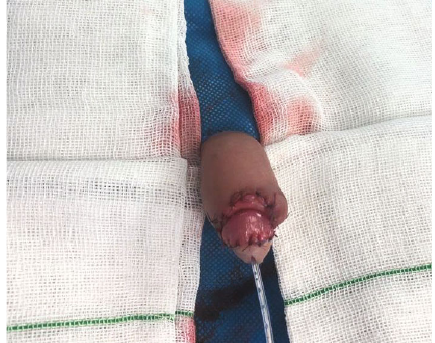
Figure 2: Penis pink appearance in the postoperation